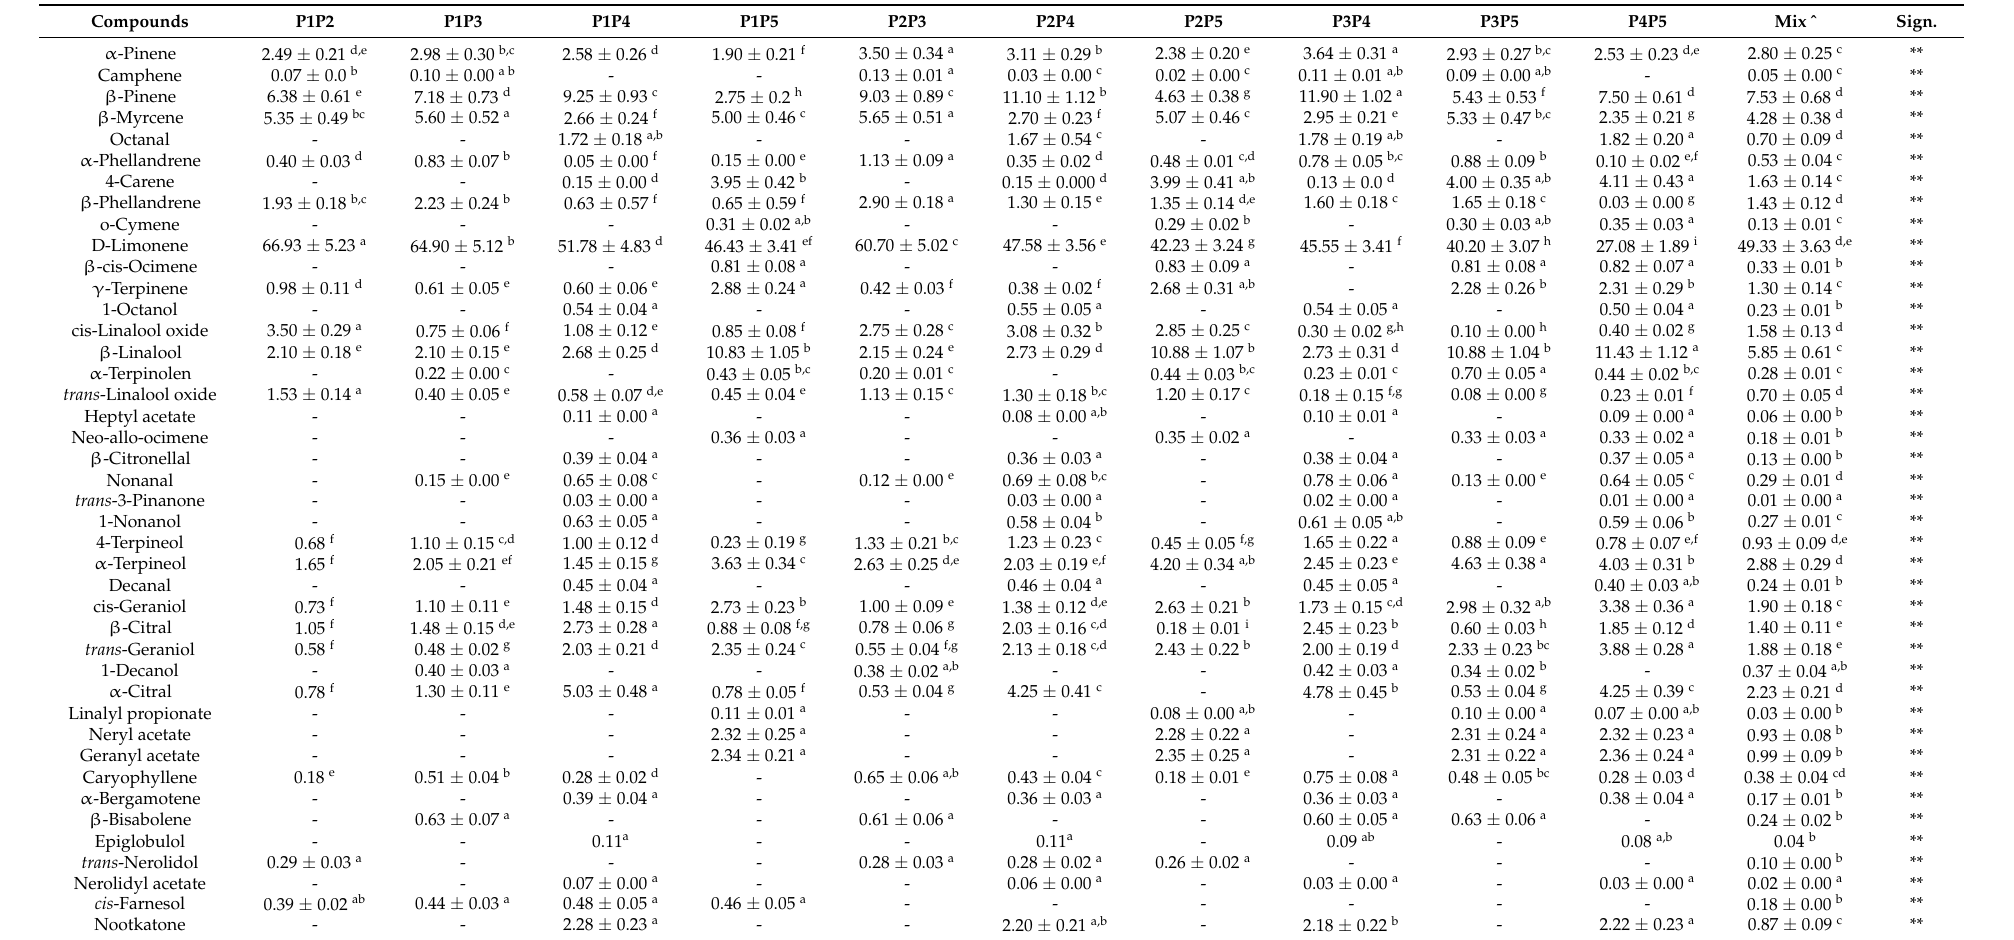
Table 2. Composition (%) of C. maxima EO blends (1:1 v / v